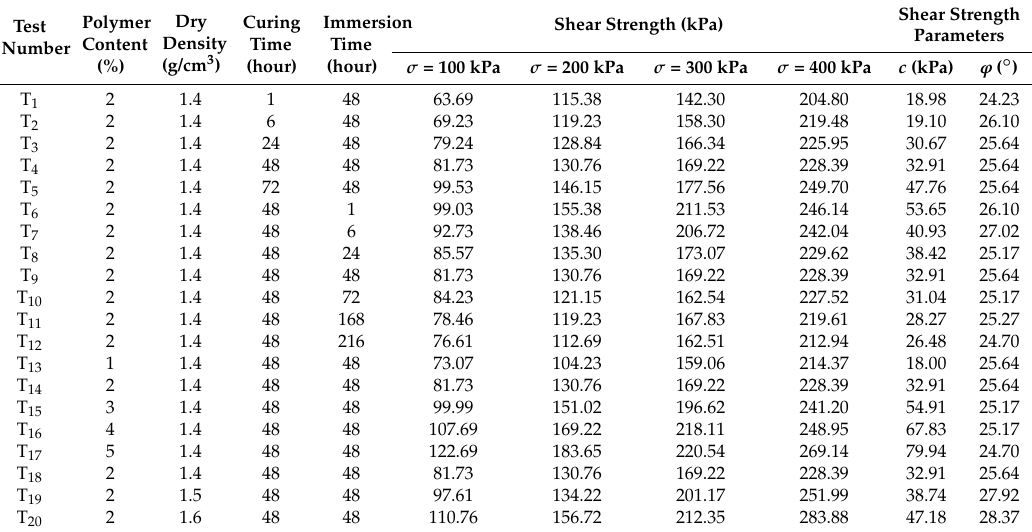
Table 3. The direct shear test results of the specimens after